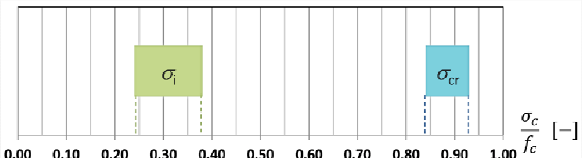
Fig. 5. Intervals of cracking initiating stress σ i and critical stress σ cr levels in self-compacting